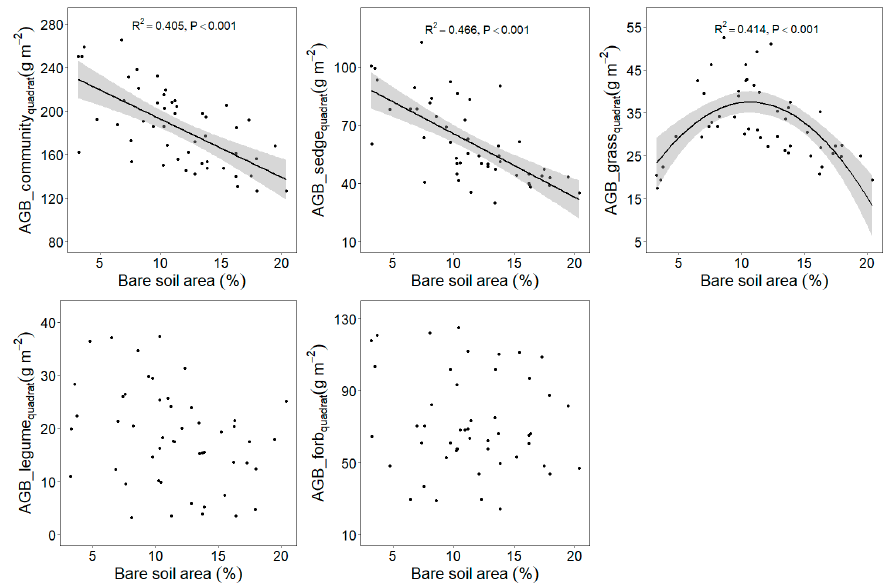
Figure 3. Relationship between plant aboveground biomass at quadrat scale and the bare soil area (%) in the disturbed plots pika across five sites based on a linear model (LM). AGB, aboveground biomass.